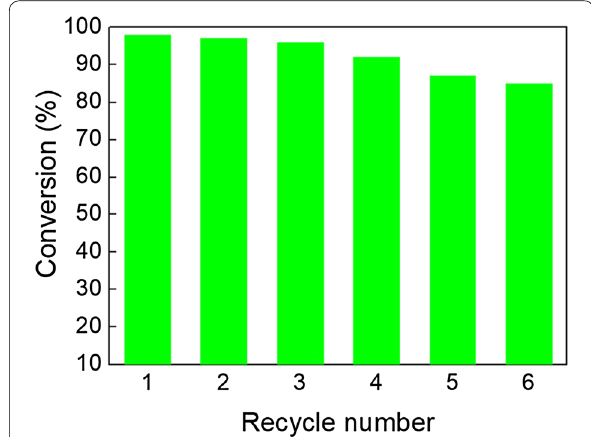
Fig. 5 Reuse of the CuO–GO nanocomposite catalyst in the heterogeneous reduction of 4‑nitrotoluene. Reaction